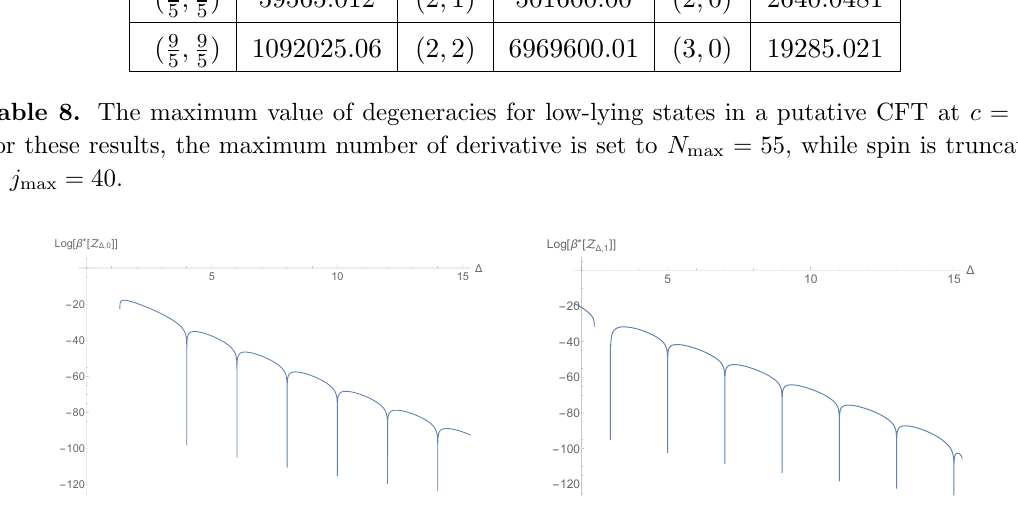
Figure 11. The extremal functional (cid:12) (cid:3) acting on spin-0 (left) and spin-1 (right) primaries at c = 16 and (cid:1) t =